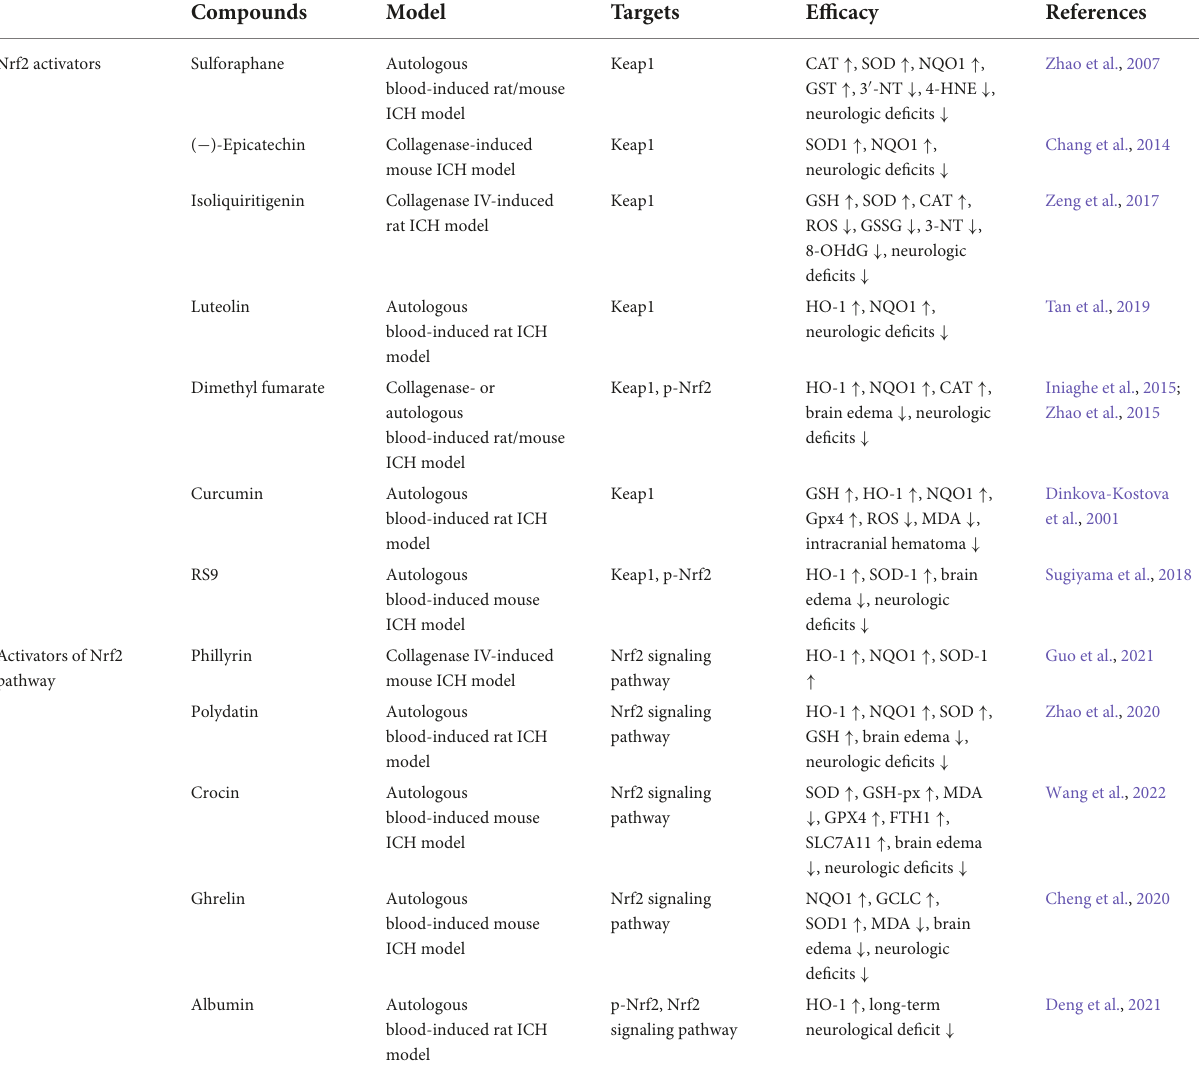
TABLE 1 The activators of Nrf2 and Nrf2 pathway in experimental ICH